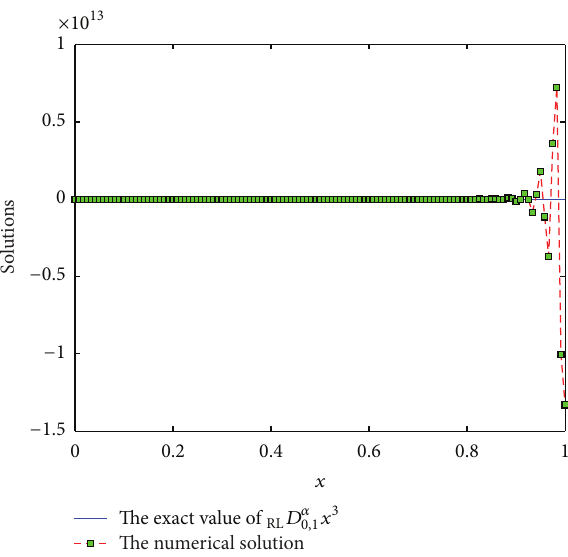
Figure 10: The exact value of 𝑝 = 8 for 𝛼 = 0.5 and step length of ℎ = 1/120 .